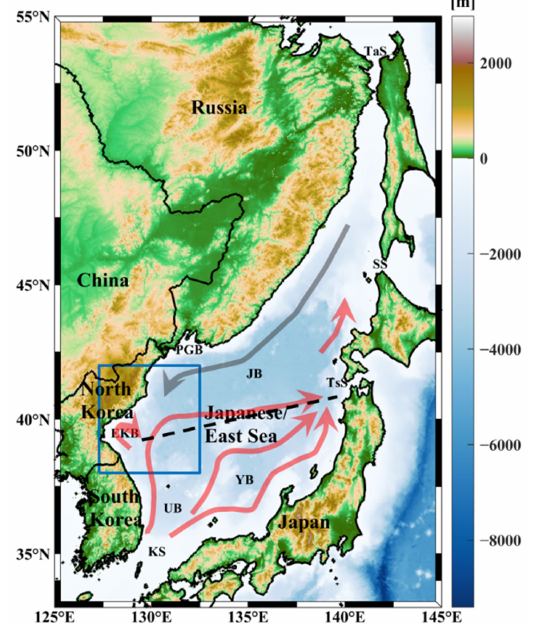
Figure 1. The topography (background color) in the study area and sea surface current schematic figure (arrows). The blue box is the extended EKB area (127.3°E − 132.5°E, 38°N − 42°N), and the black dotted line is the subpolar front. The red arrows indicate warm currents, while the gray arrows indicate cold currents. EKB: East Korea Bay; JB: Japan Basin; UB: Ulleung Basin; YB: Yamato Basin; PGB: Peter the Great Bay; KS: Korea Strait (Tsushima Strait); SS: Soya Strait; TaS: Tatarsky Strait; TsS: Tsugaru Strait.